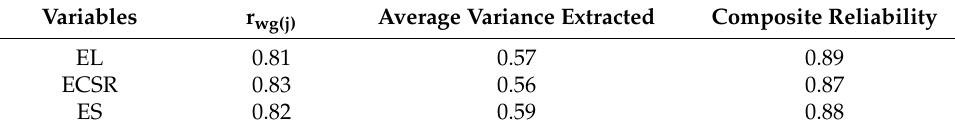
Table 3. The analysis results of